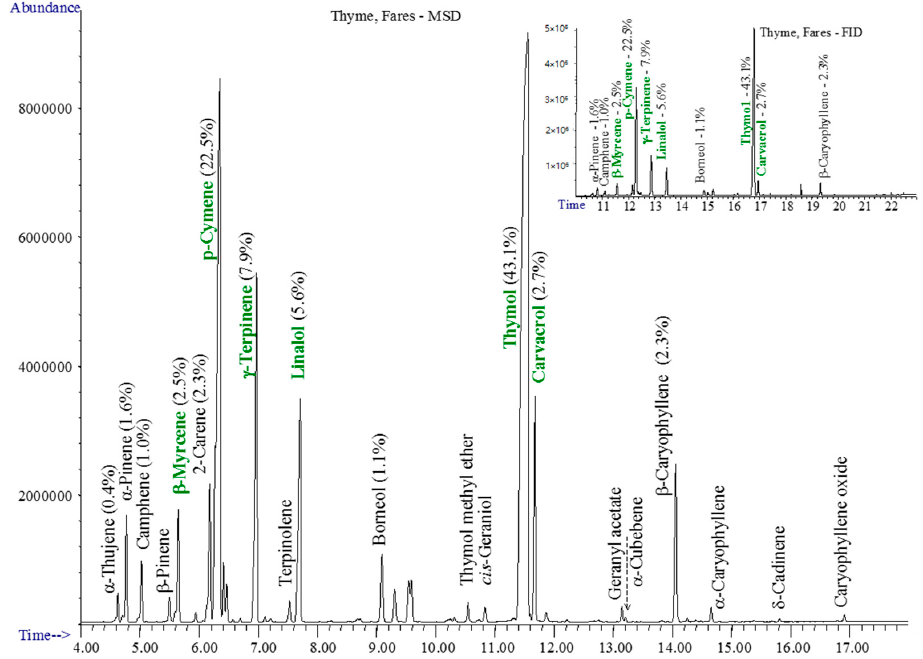
Figure 1. The GC-MSD and GC-FID (insert) chromatograms of thyme oil.